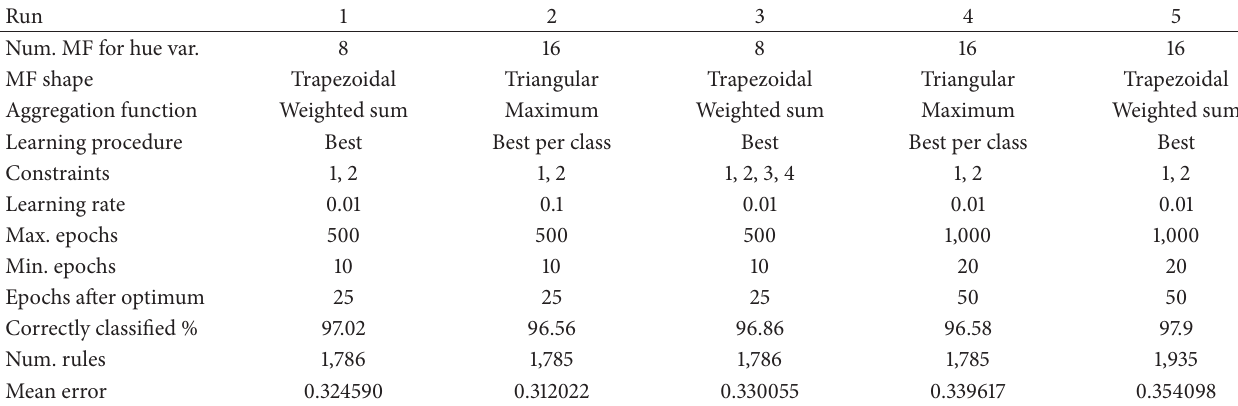
Table 3: Round 3. Data separated by gender for some species (see Appendix); 3,660 patterns presented for use in training; the learning constraints on the fuzzy sets are as follows: 1: keep their relative order, 2: always overlap, 3: be symmetrical, and 4: intersect at 0.5. Run 1 2 3 Num. MF for hue var.